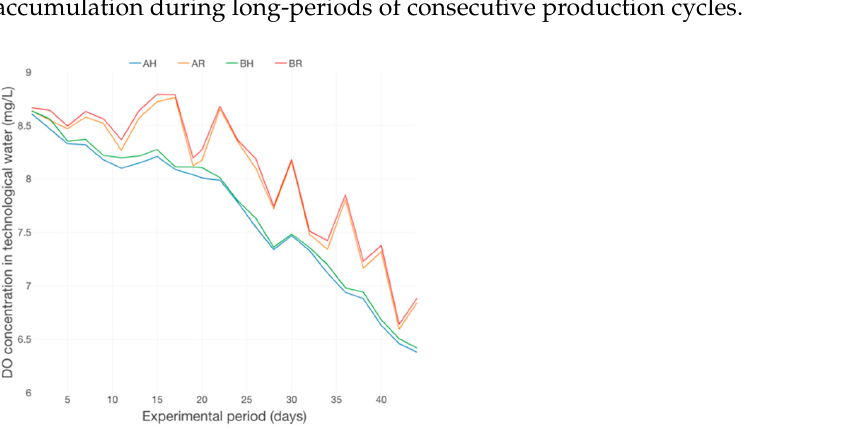
Figure 21. The dynamics of DO concentration in technological water for each of the experimental variants.